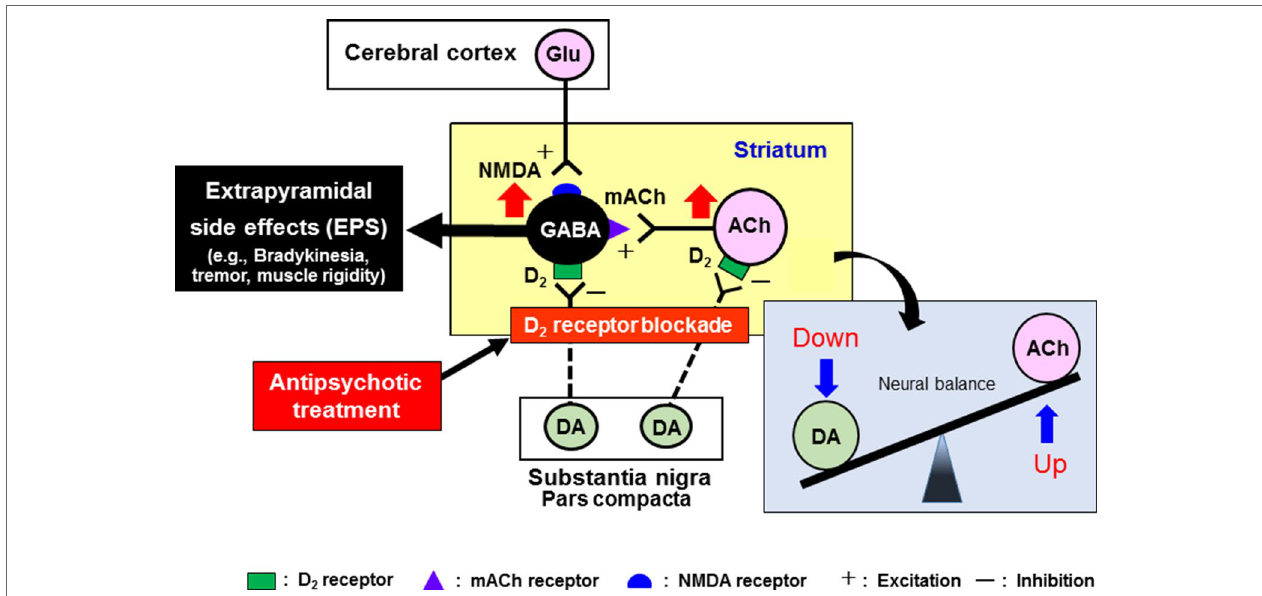
FIGURE 4 | Pathophysiological mechanisms underlying the induction of extrapyramidal side effects (EPS) with antipsychotic treatments. Antipsychotic drugs commonly exert dopamine D 2 blocking actions in the striatum, which relieves the striatal neurons (GABA-containing medium spiny neurons and acetylcholine (ACh)-containing interneurons) from negative regulation by the nigrostriatal dopaminergic neurons. Thus, overall activation of striatal medium spiny neurons by antipsychotics evokes EPS (e.g., bradykinesia, tremor, and muscle rigidity). Antipsychotic-induced EPS can be alleviated by anti-muscarinic drugs (e.g., trihexyphenidyl and biperidene), which reverses the imbalance between dopamine and ACh neuron activities in the striatum. However, due to the side effects, these agents are not recommended for the elderly